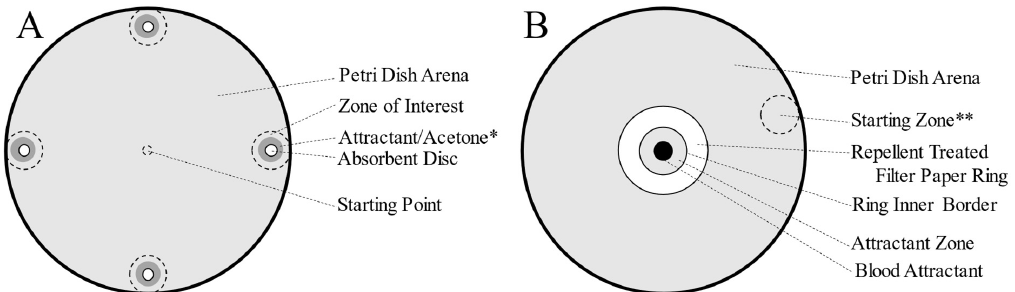
Figure 2. Diagrams showing the assays used in this study. ( A ) Four-disc assays (repellency longevity and repellency in presence of aggregation pheromone components). A 15 cm Petri dish was lined with filter paper, and four absorbent filter paper discs (one of which contained a repellent compound) were evenly spaced close to the perimeter of the arena. Trials began with a bed bug in the center of arena. * Attractant/acetone was present under the absorbent filter paper discs only in the second set of experiments (with aggregation pheromone components). ( B ) Repellent activity in presence of food source. A 15 cm Petri dish was lined with filter paper, and a centrifuge cap filled with human blood was placed in the center of the arena and surrounded by a ring of filter paper treated with a repellent compound. ** Starting zone was randomized, but always along the border of the